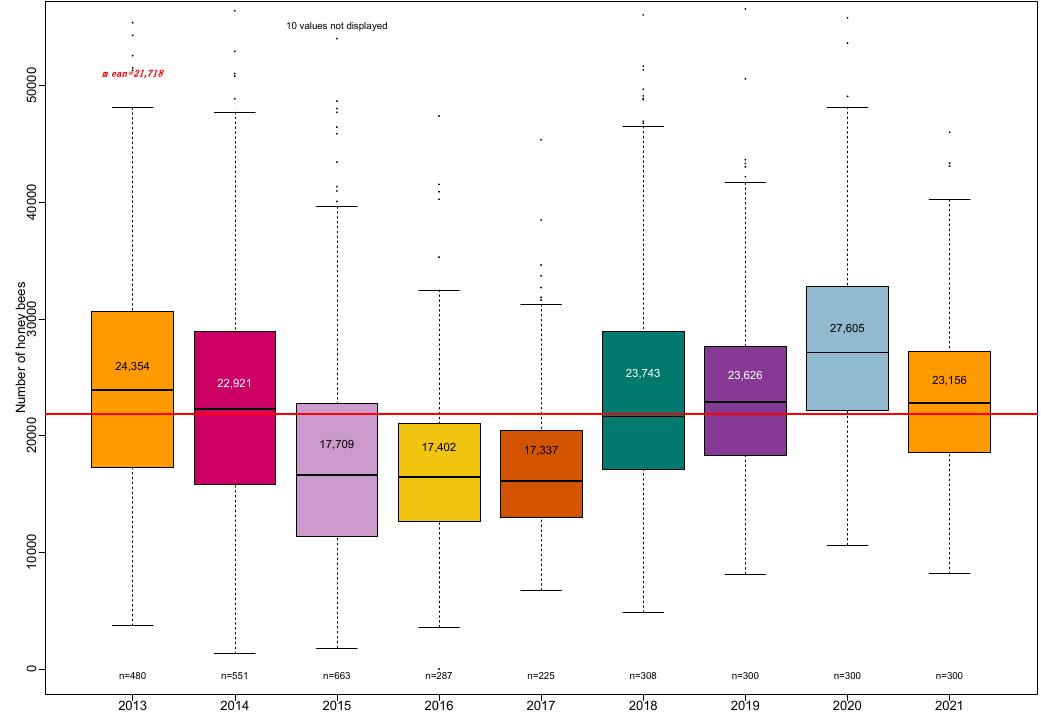
Figure A2. Evolution of the number of honey bees per year from 2013 to 2021.